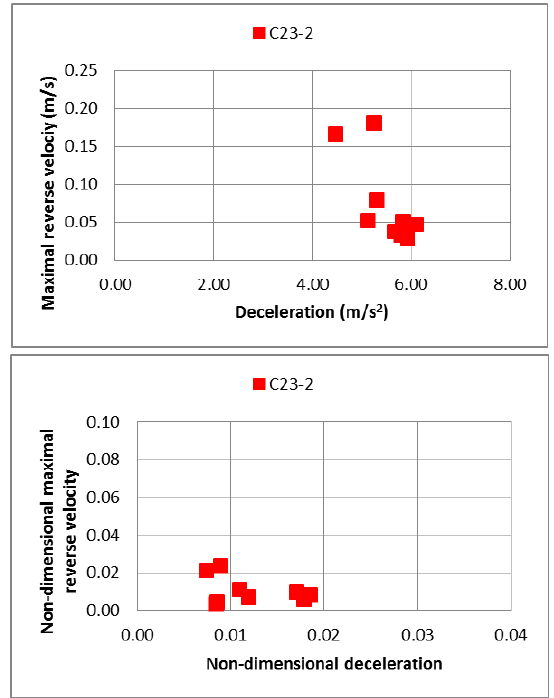
Fig. 18. Dynamic properties – reverse velocity dependence on system deceleration